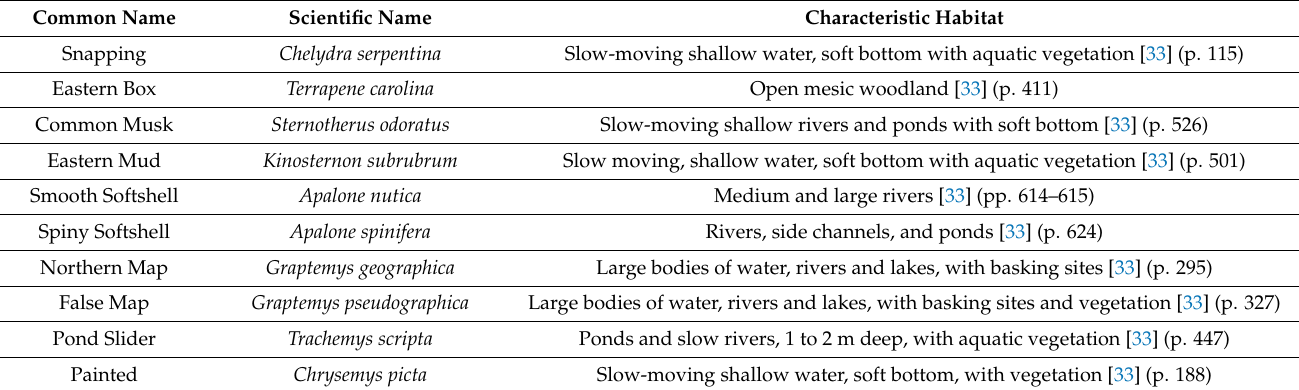
Table 3. Summary of turtle species and habitats.